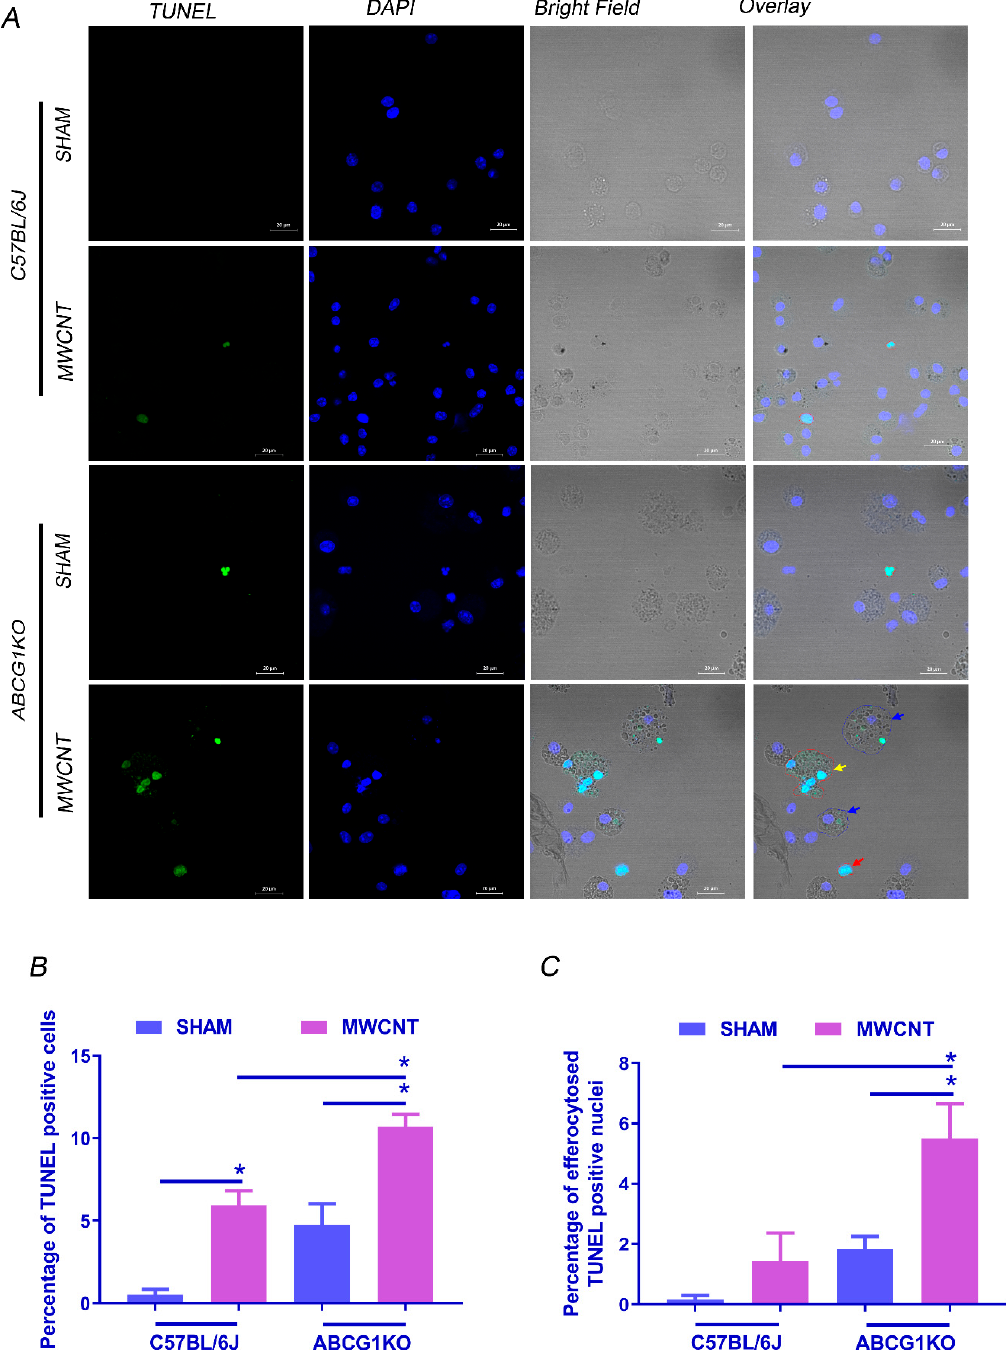
Figure 4. Myeloid ABCG1 deficiency increases the percentage of efferocytosed apoptotic cells after MWCNT instillation. ( A ) Representative images showing TUNEL staining for BAL cells (40 × ). Cytospins of BAL cells from C57BL/6J and ABCG1 KO mice either sham or MWCNT instilled were stained with TUNEL reagent for DNA fragmentation (green) and nuclear stain, DAPI (blue). Bright field showing non-engulfed apoptotic cells (red arrow), efferocytosed TUNEL+ nuclei (blue arrow) and multi-nucleated apoptotic cell (yellow arrow). ( B ) Graphical representation of the per- centage of TUNEL positive cells in BAL cytospins. ( C ) Graphical representation of the percentage